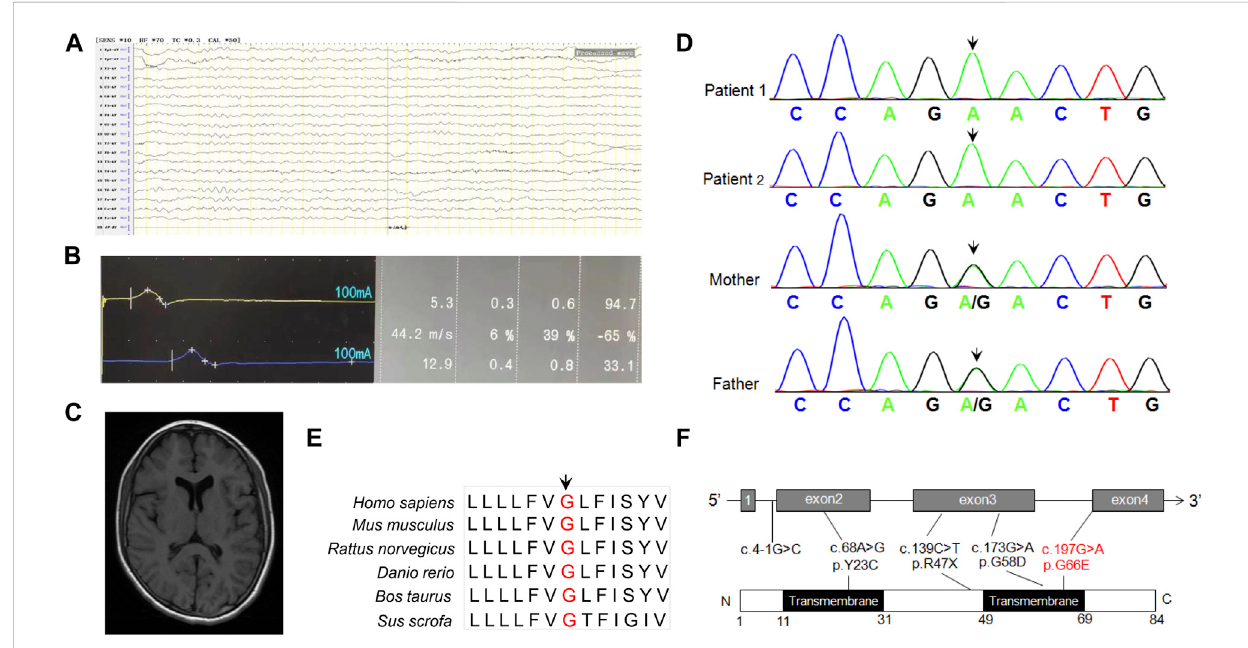
FIGURE 1 (A) EEG prompts slow background activity. (B) The motor nerve conduction amplitude of the right nervus peroneus communis was decreased, the terminal latency was prolonged, and the speed was normal, indicating that the axon and demyelination were damaged. (C) MRI shows abnormal signal fociinthewhitematterofthebrain,anddemyelinationchangeintheyoungersister. (D) Sangersequencingof DPM2 variantsinthefamilyofthisstudy. (E) ConservationanalysisofDPM2proteinamongdifferentspecies.Thepositionofthevariantsataminoacid66isindicatedinredandhighlyconserved throughout all indicated species. (F) Scheme of the distribution of DPM2 variants. The variants in red were reported in the present